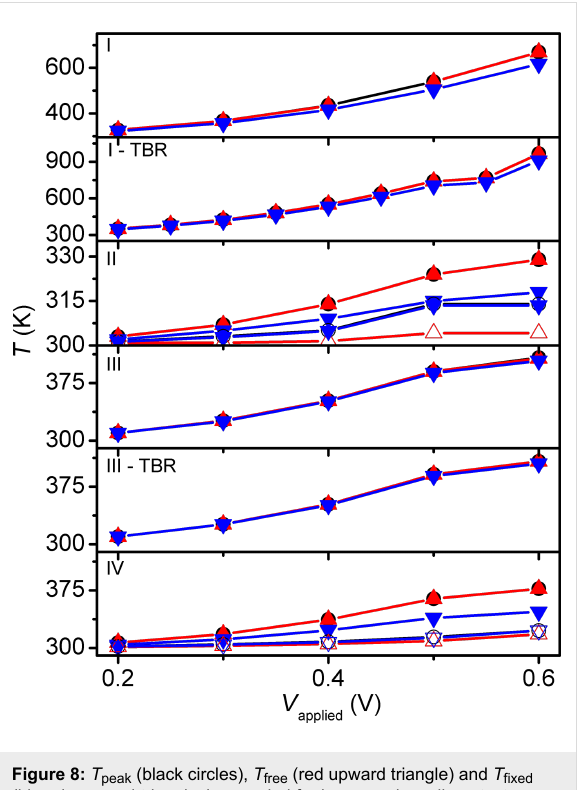
Figure 8: T peak (black circles), T free (red upward triangle) and T fixed (blue downward triangles), recorded for large- and small-contact con- figurations. Simulations carried out for SiO 2 passivation. Configura- tions II and IV feature positive polarity (solid symbols) and negative polarity (open symbols). Configurations I and III are simulated with and without thermal boundary resistance (TBR) at the passivation–Cu